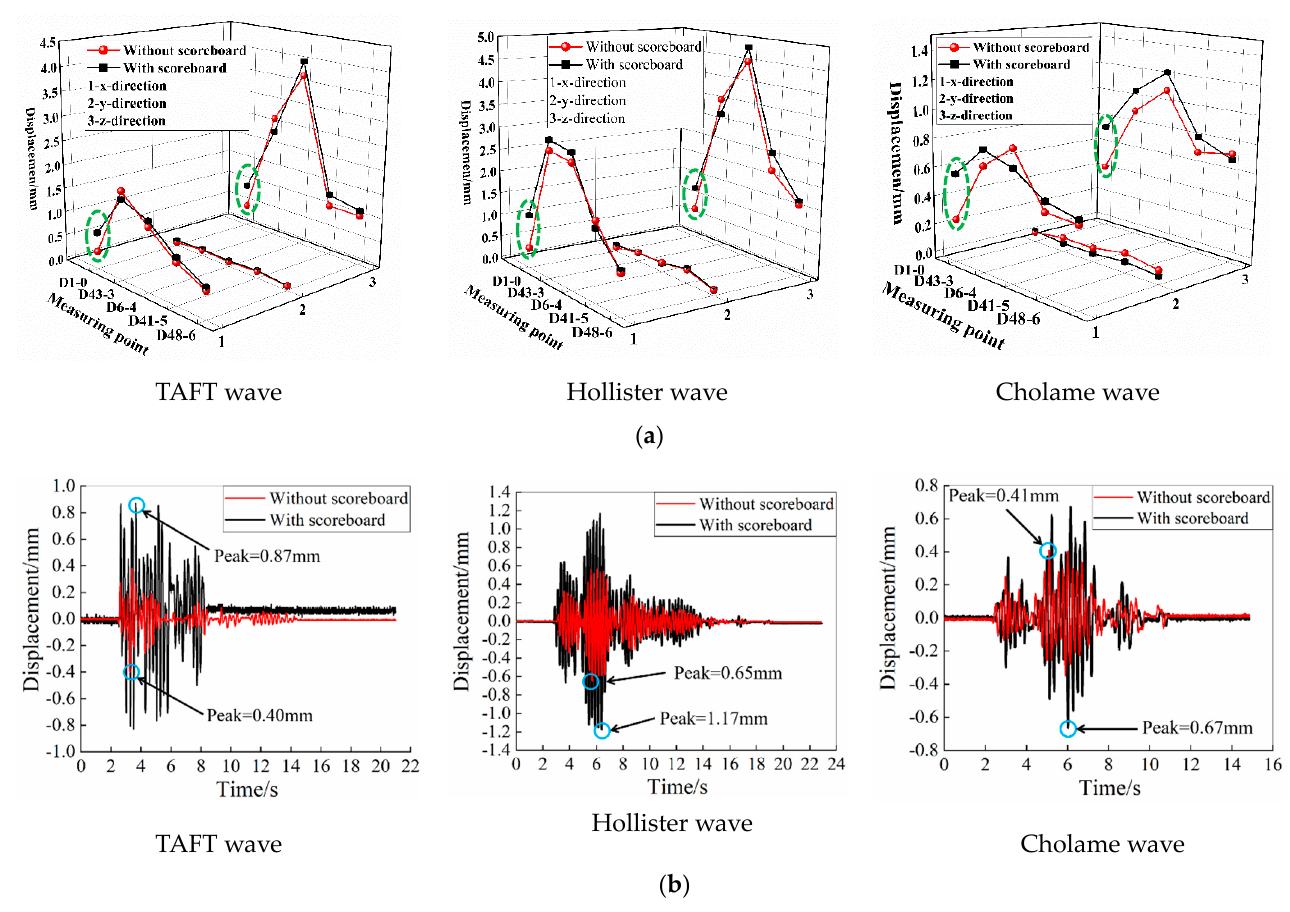
Figure 15. Displacement response comparison: ( a ) Peak displacement; ( b ) Displacement time-history curves of measuring point D1-0 in the z-direction.